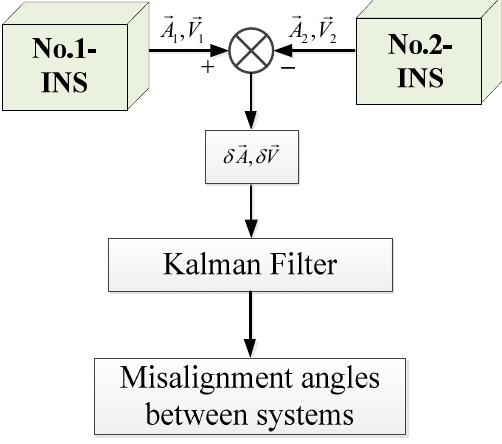
Figure 3. The misalignment angles calibration scheme.